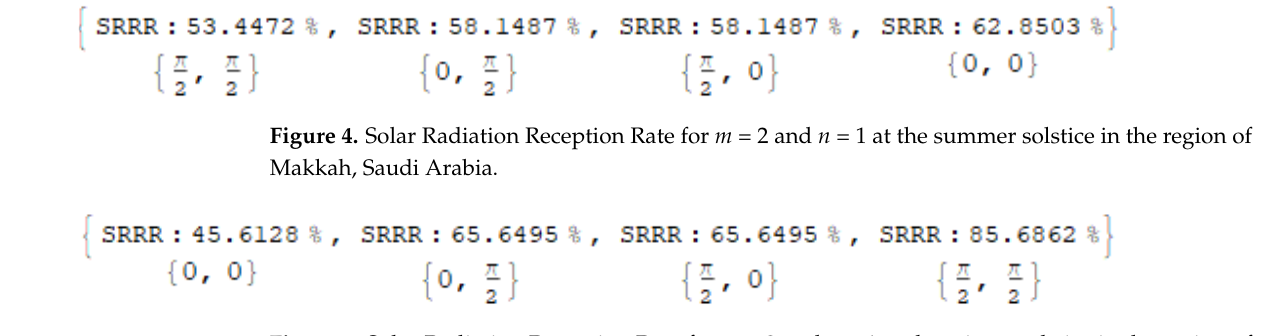
Figure 5. Solar Radiation Reception Rate for m = 2 and n = 1 at the winter solstice in the region of Makkah, Saudi Arabia. Figure 7. Solar Radiation Reception Rate for m = 2 and n = 2 at the summer solstice in the region of Makkah, Saudi Arabia.